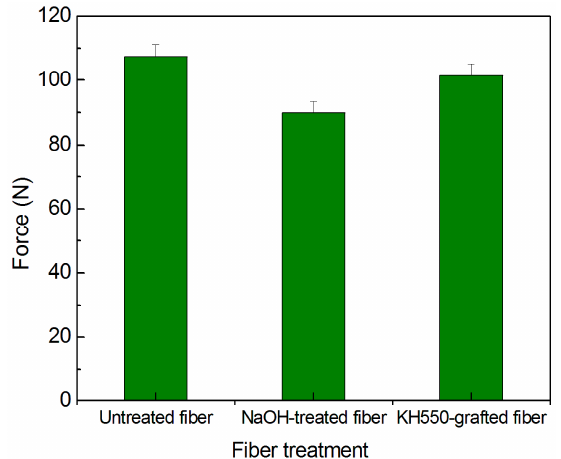
Figure 2. Effect of process mode on tensile strength of fibers.